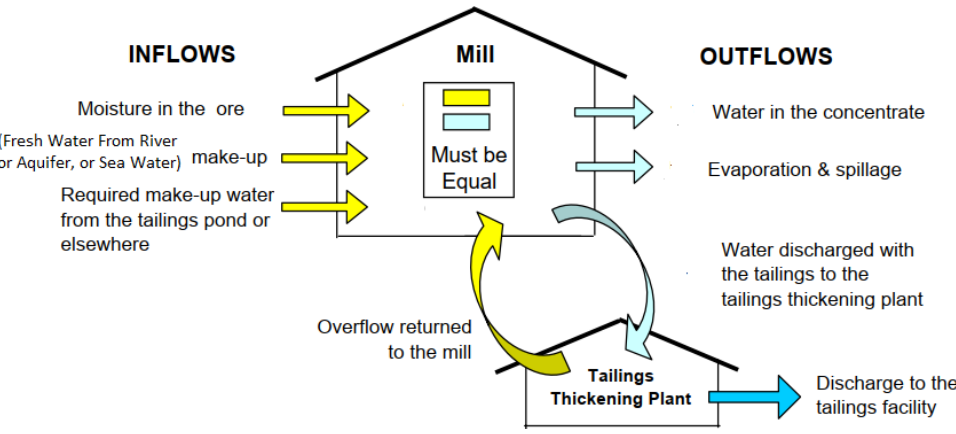
Figure 3. Typical flows into and out of a mill and thickening mining plant.